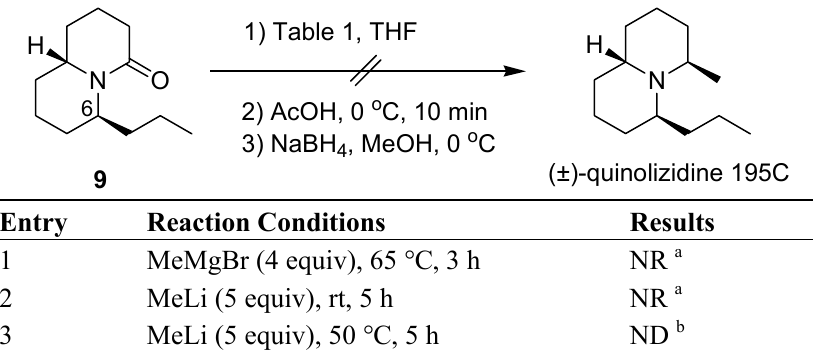
Table 1. Reactions of compound 9 with a methyl